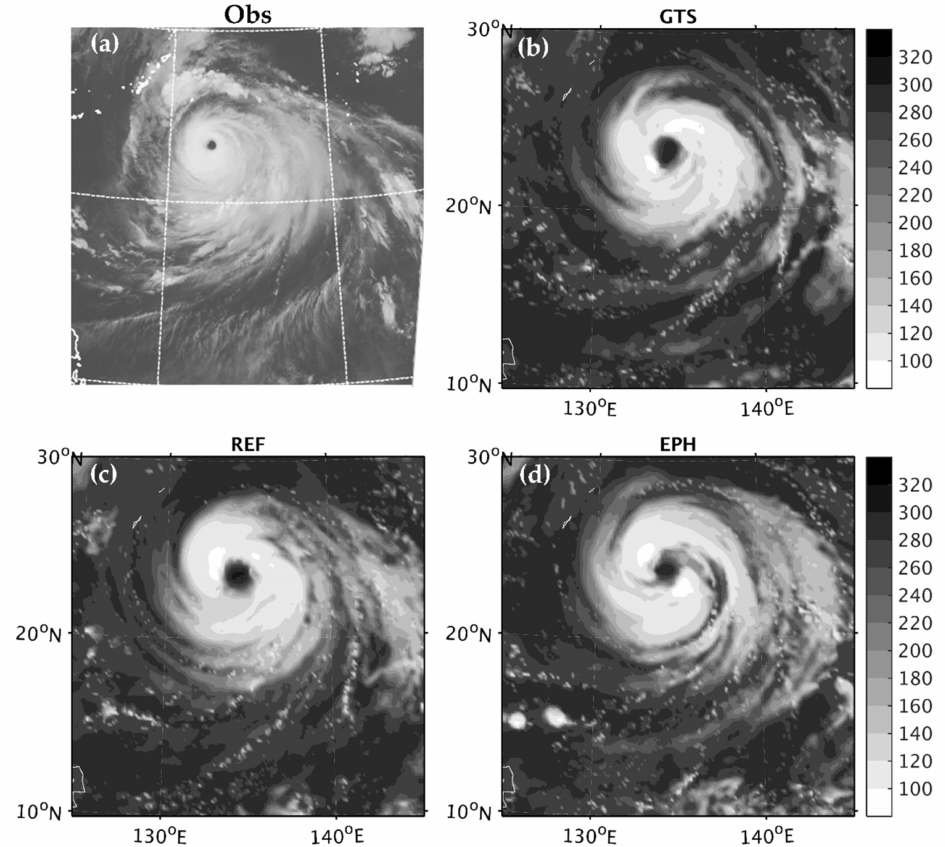
Figure 7. ( a ) Infrared satellite image from Himawari-8, and the simulated outgoing longwave radiation flux (W m − 2 ) at 1800 UTC 4 September 2020 (54-h forecast) for ( b ) GTS, ( c ) REF, and ( d )